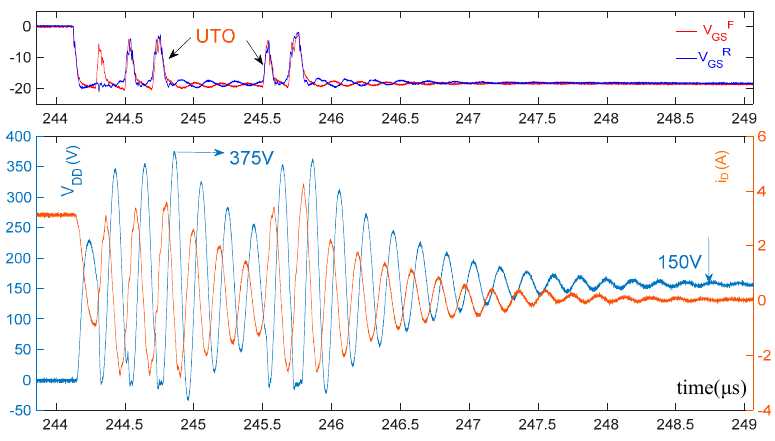
Figure 5. UTO phenomenon during turn-off transient @ V in = 150 V.